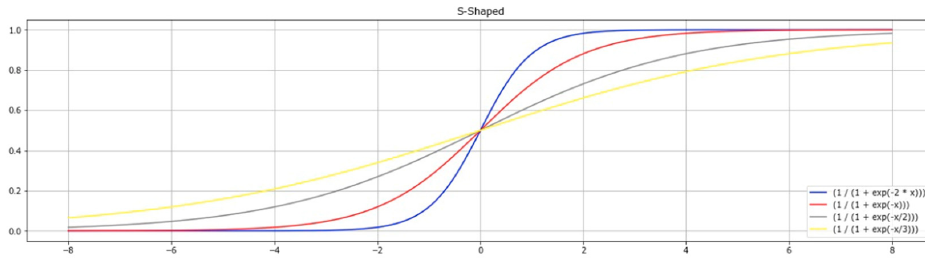
Figure 4. S-shaped transfer function ( S 1– S 4).